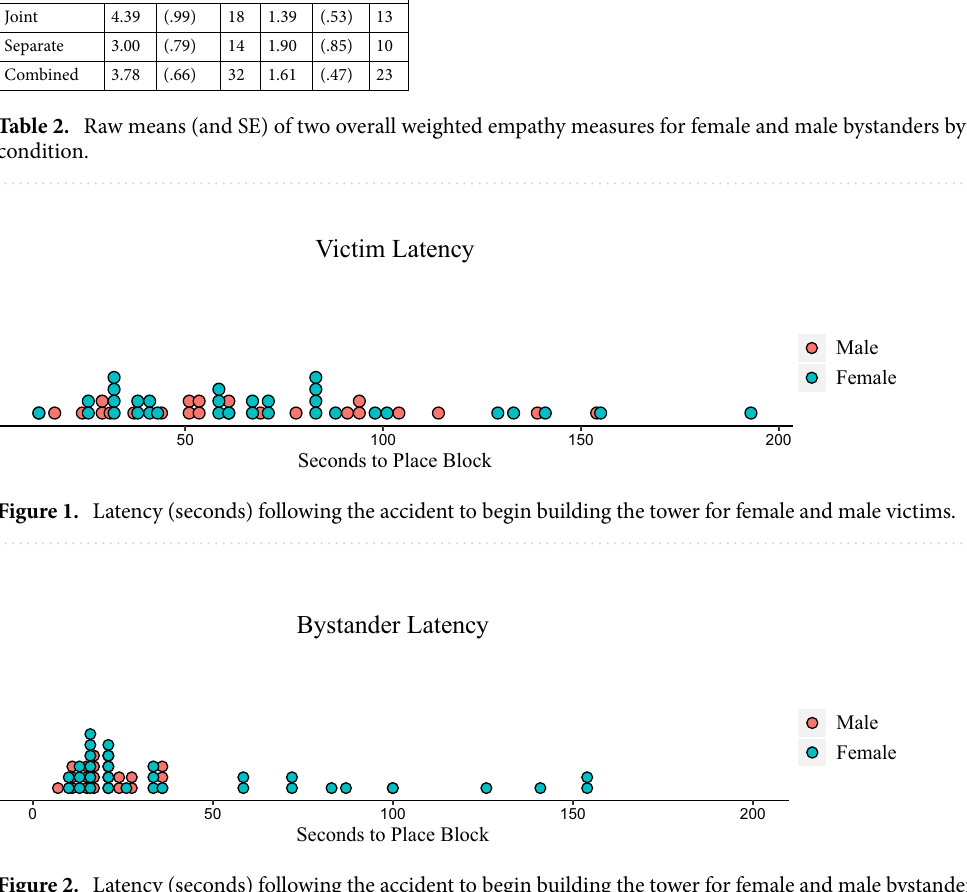
Figure 2. Latency (seconds) following the accident to begin building the tower for female and male